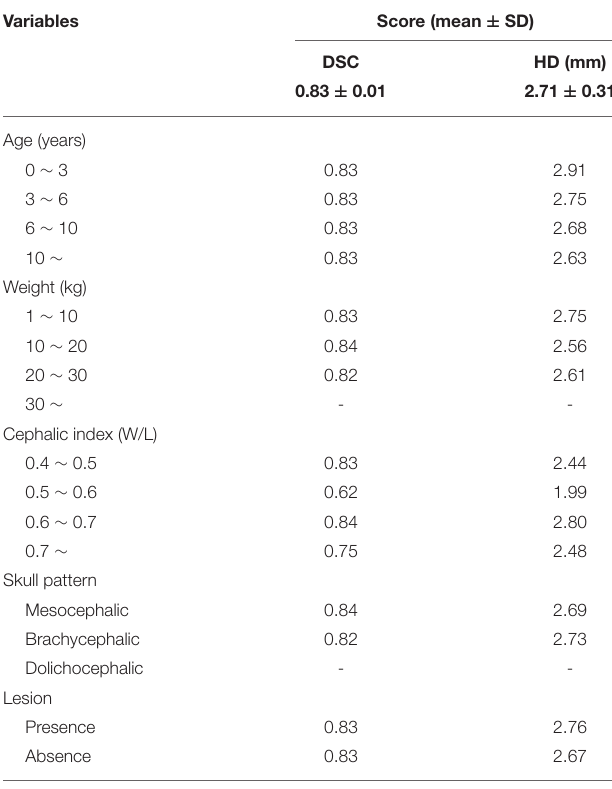
TABLE 2 | Accuracy correlation according to variables in the test set.